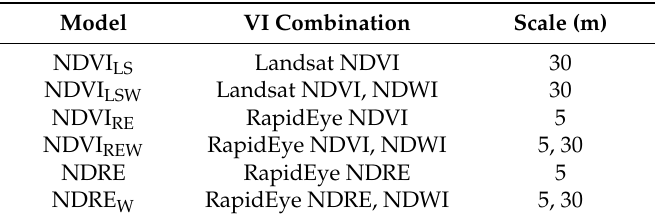
Table 1. Model framework description. Each model is structured as GPP ~ PAR ˆ TA ˆ VI where VI is represented by the corresponding Table entry above, while PAR and TA are derived from on-site instrumentation. Acronym definition: GPP (gross primary productivity), PAR (photosynthetically active radiation), TA (air temperature), VI (vegetation index), NDVI (normalized difference